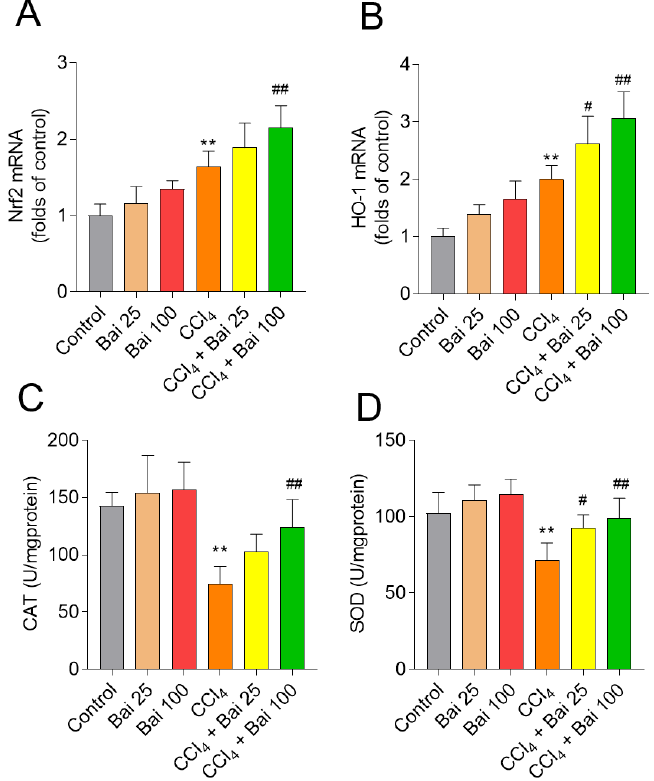
Figure 5. Effects of baicalein supplementation on the antioxidant defense pathways in liver tissues of mice challenged with CCl 4 . ( A ) Nrf2 mRNA; ( B ) HO-1 mRNA; ( C ) CAT activity; and ( D ) SOD activity. Data are presented as mean ± SD ( n = 6). ** p < 0.01, compared to the control group; # p < 0.05 or ## p < 0.01 compared to the CCl 4 model group. Bai: baicalein.